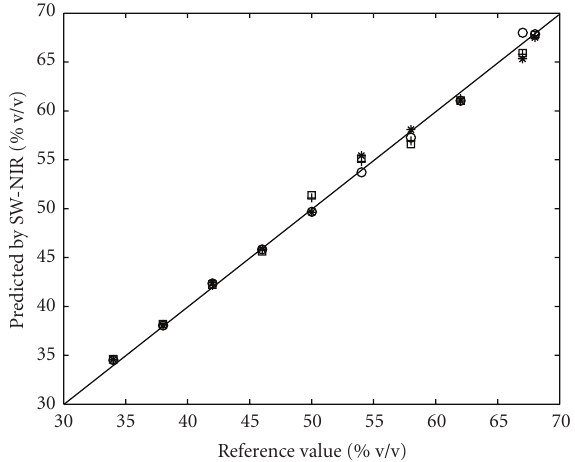
Figure 7: Reference value versus SW-NIR predicted value by using GLSW filter. Circle: validation set at 25 ◦ C; Plus: validation set at 15 ◦ C; Star: validation set at 35 ◦ C; Square: validation set at 40 ◦ C. Table 4: Results of GLSW model for di ff erent α values.